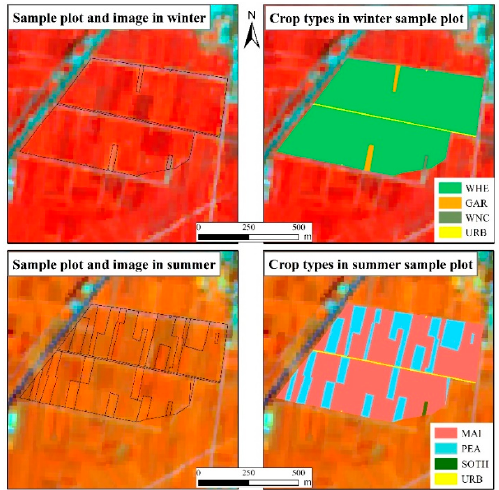
Figure 3. Ground sample plot and images in different seasons.